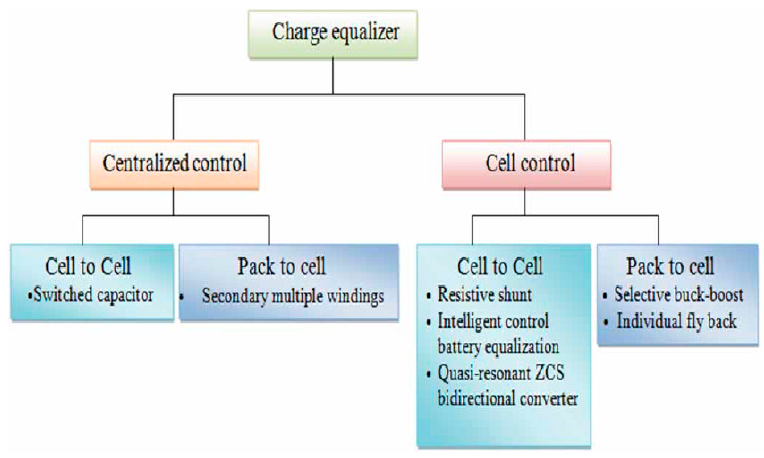
Figure 2. Block diagram for charge equalizer (ZCS: Zero-Current-Switching).